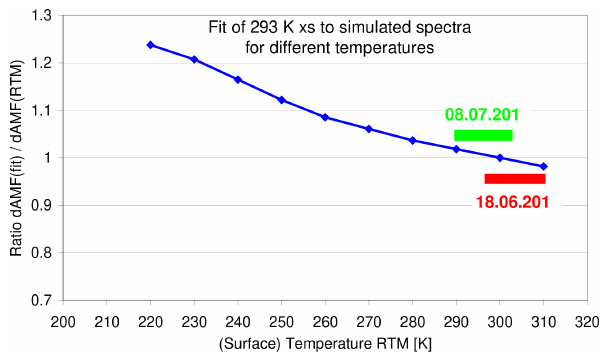
Figure 13. Ratios of the O 4 dAMF obtained from simulated spectra for different surface temperatures by the corresponding O 4 dAMFs derived from radiative transfer simulations. The results represent MAX-DOAS observations at low-elevation angles (2 to 3 ◦